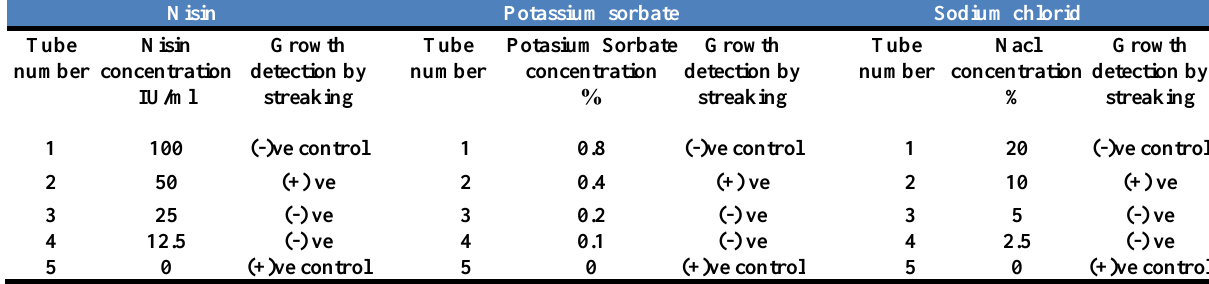
Table, 3: The minimum inhibitory concentrations of Nisin, Potassium sorbate and Sodium chlorid against Staph. aureus by the broth dilution method . Nisin